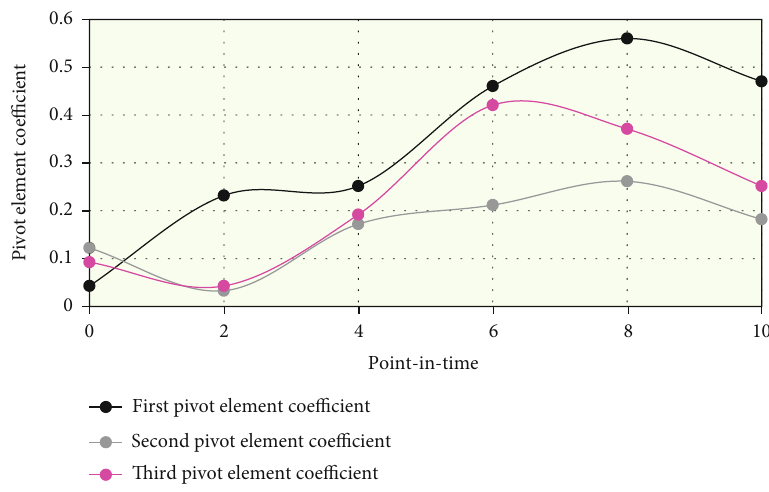
Figure 8: Changes of di ff erent element coe ffi cients.